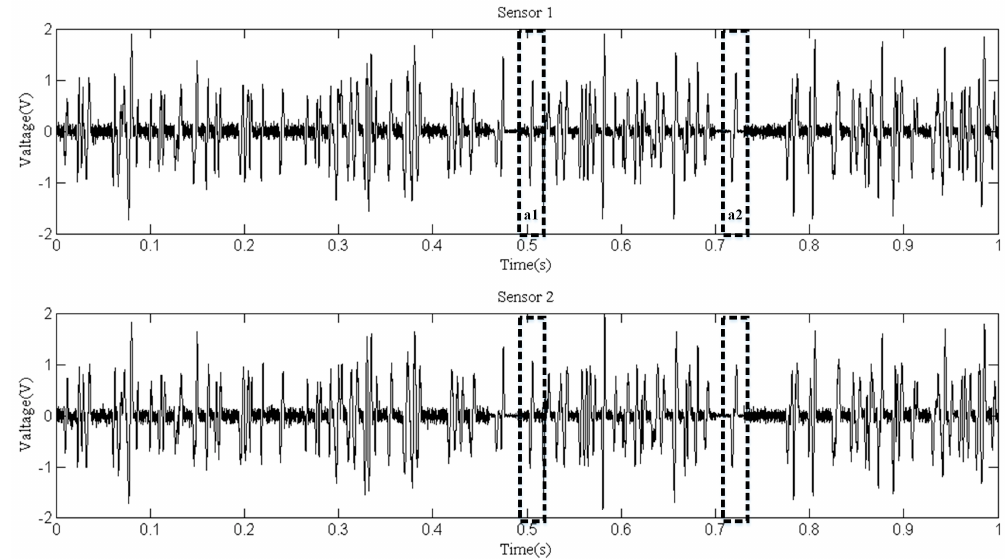
Figure 6. Extracted signals.